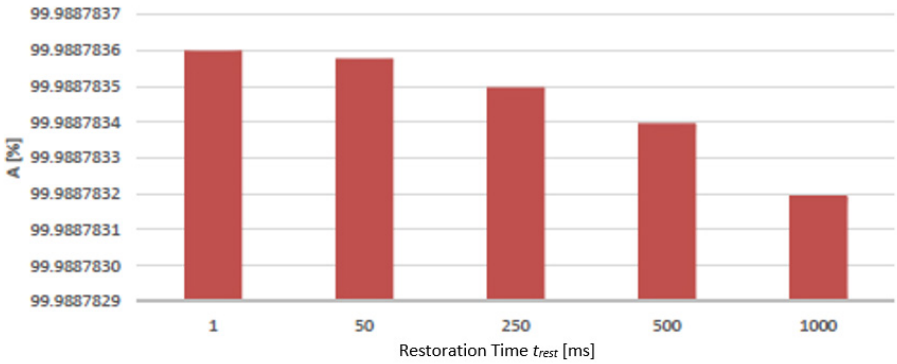
Figure 7. The network availability of the dual-parented Type B protection for selected restoration times.